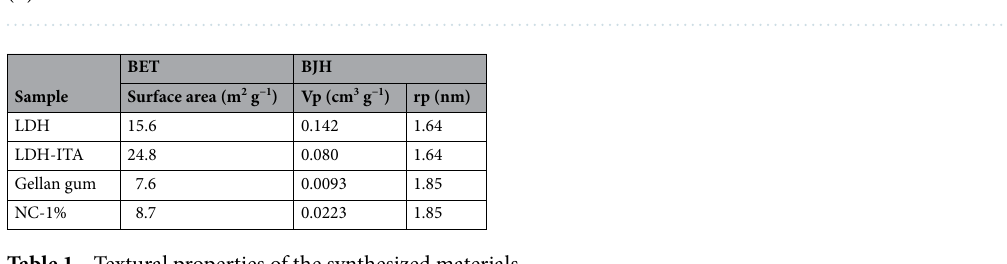
Figure 5. The N 2 adsorption/desorption isotherms of LDH ( a ), LDH-ITA ( b ), pure gellan gum ( c ), and NC-1% ( d ).